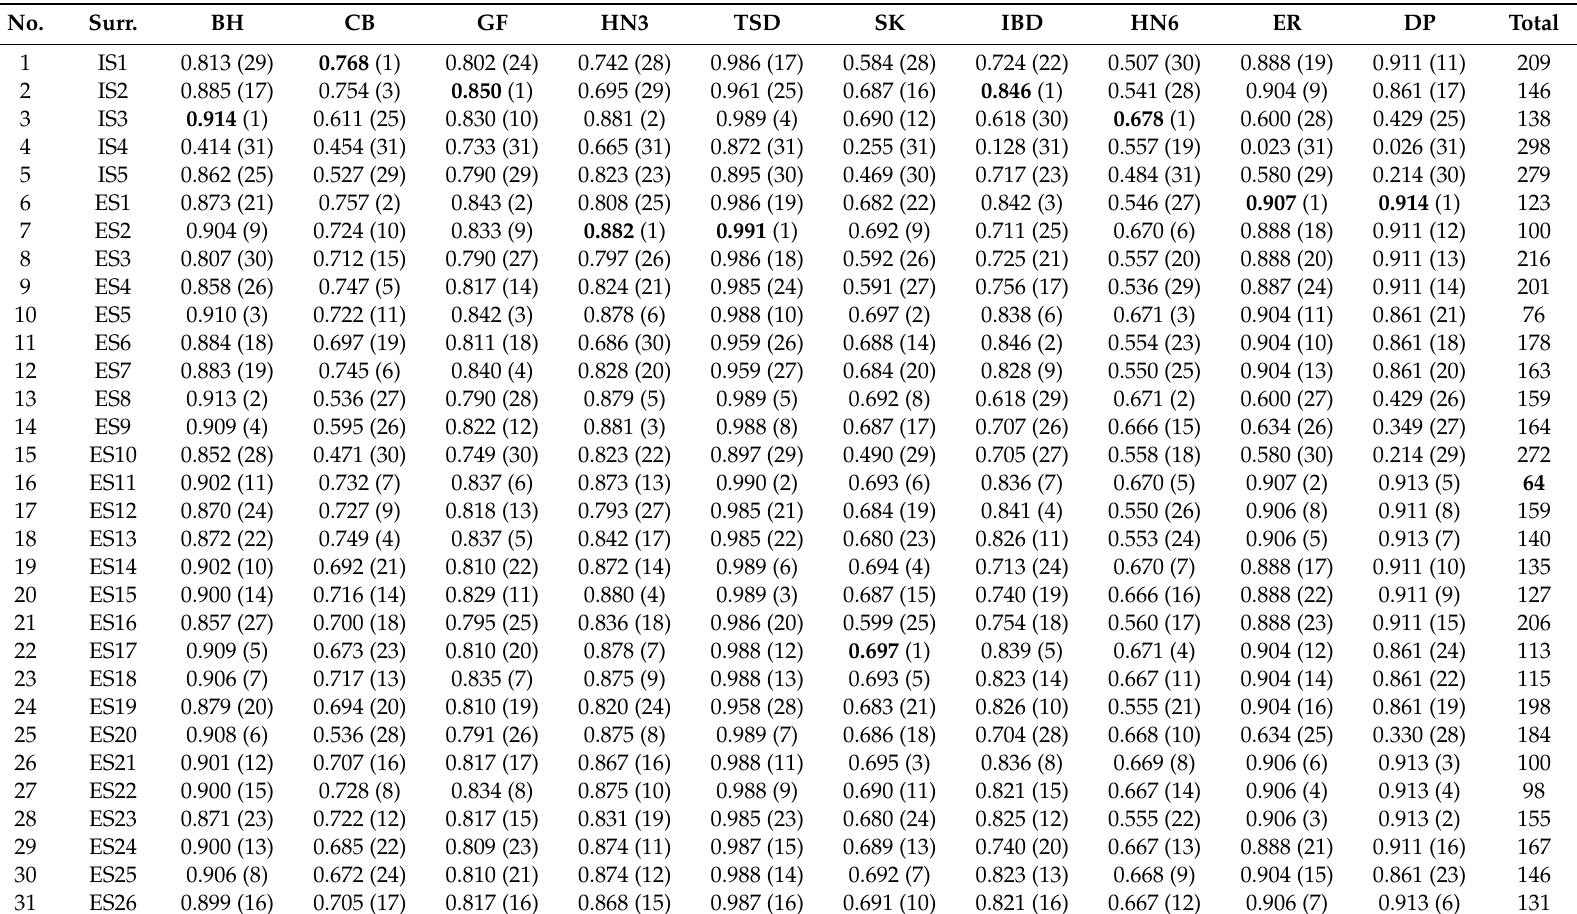
Table 3. Comparison of performance measure coe ffi cient of determination ( R 2 ) for all test